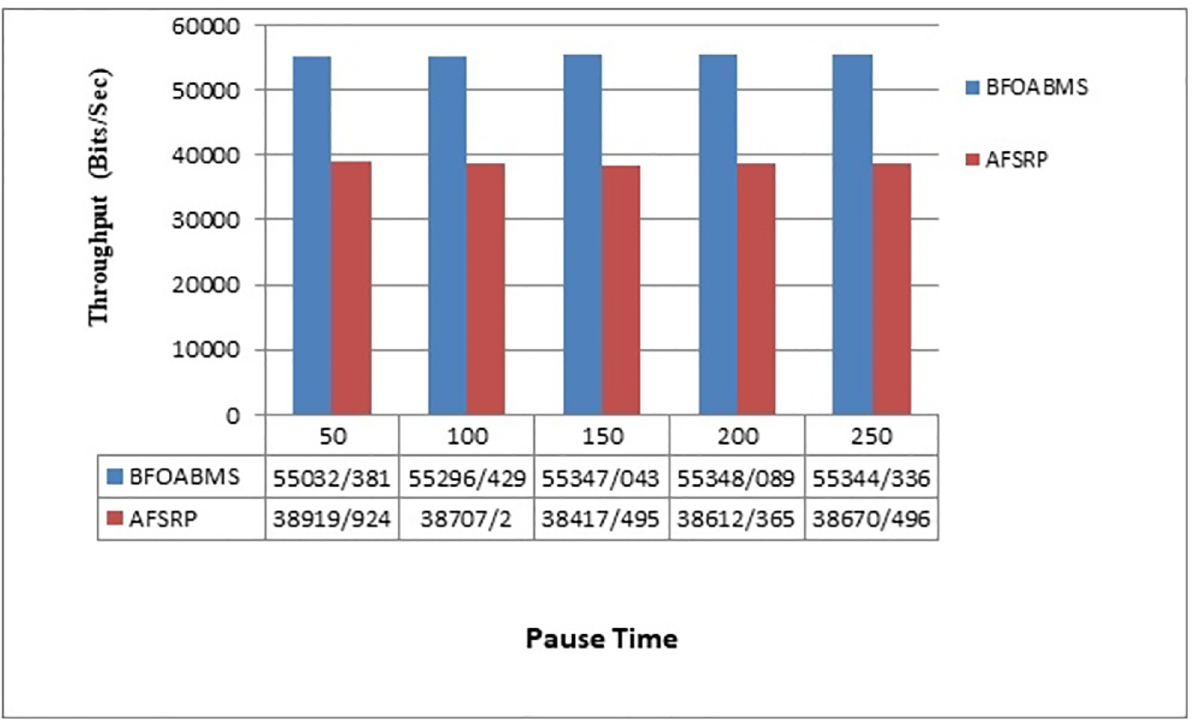
Fig 8. Throughput rate.